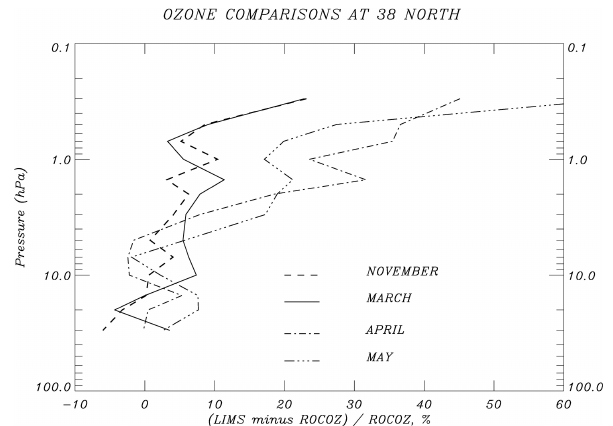
Figure 15. Monthly zonal mean V6 daytime ozone minus ROCOZ ozone (in %) for 4 months at 38 ◦ N.